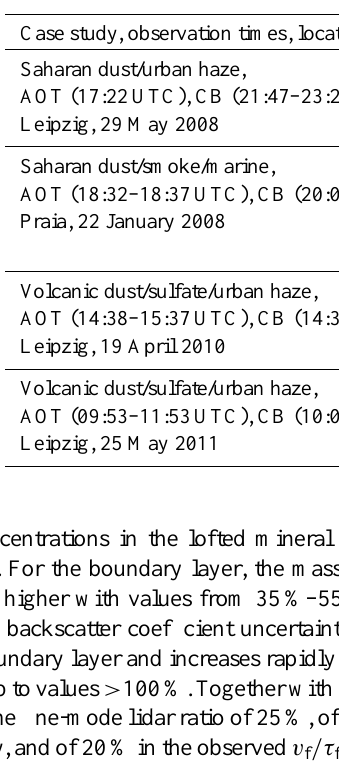
Table 3. Aerosol optical thickness (AOT), column–integrated backscatter coefficient (CB in sr − 1 ), and column lidar ratio (AOT/CB in sr) for the four case studies shown in Figs. 2–5. All values are given for 532nm wavelength. ˚Angstr¨om exponents (AE) after O’Neill et al. (2003) for the spectral range around 500nm are shown in addition. The 532nm AOTs are obtained from the measured 500nm AOTs by means of the respective ˚Angstr¨om exponents (AE). The coarse–mode AE is set to zero in the photometer data analysis (O’Neill et al., 2003). AERONET level 2.0 data are used, except for 22 January 2008 (level